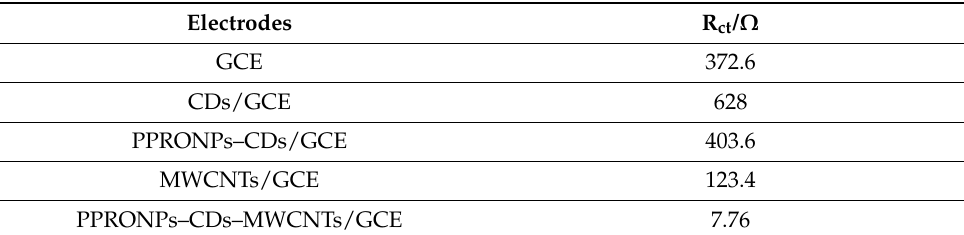
Figure 4. CV ( a ) and EIS ( b ) of GCE, CDs/GCE, PPRONPs − CDs/GCE, MWCNTs/GCE, and PPRONPs − CDs − MWCNTs/GCE in 0.1 M PBS containing 2.0 mM K 4 Fe(CN) 6 , respectively. Scan rate of 50 mV/s. EIS parameters: 100 kHz to 5 mHz, 5 mV rms, 0.22 V vs. SCE. Table 1. The values of EIS equivalent circuit elements for each electrode.